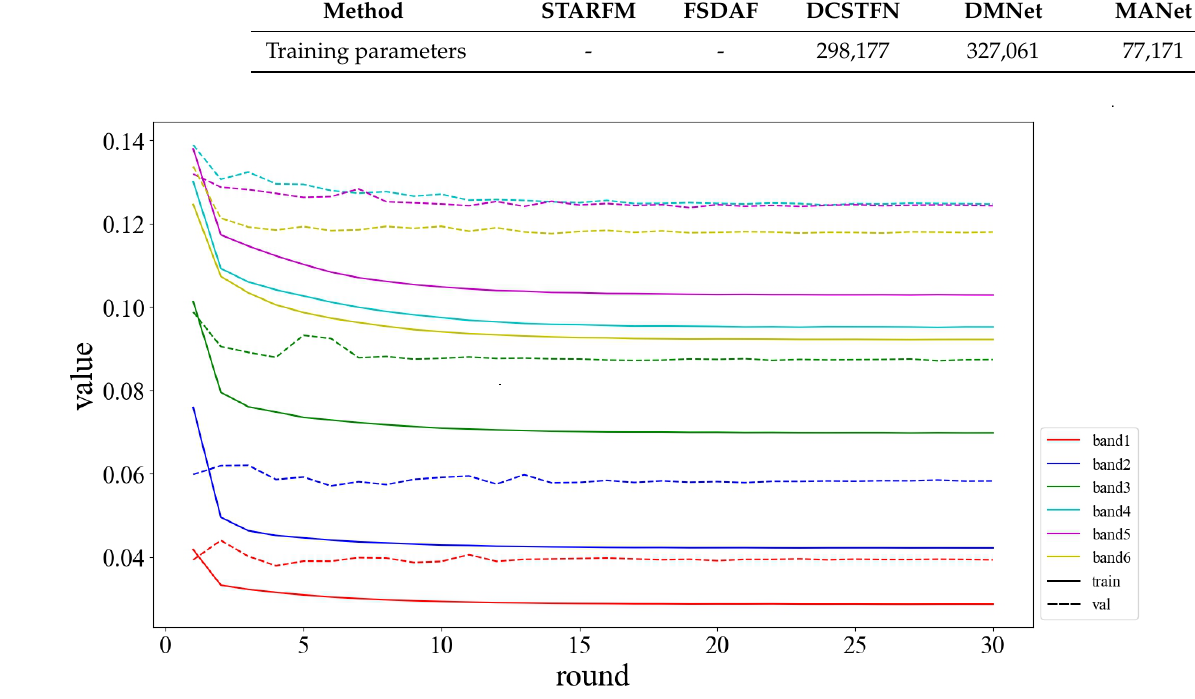
Figure 12. The loss curves of MANet for multiple bands on the training and test